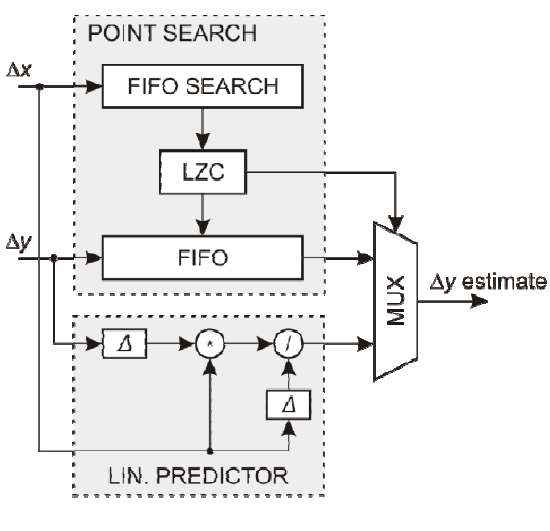
Figure 6. The structure of y -coordinate